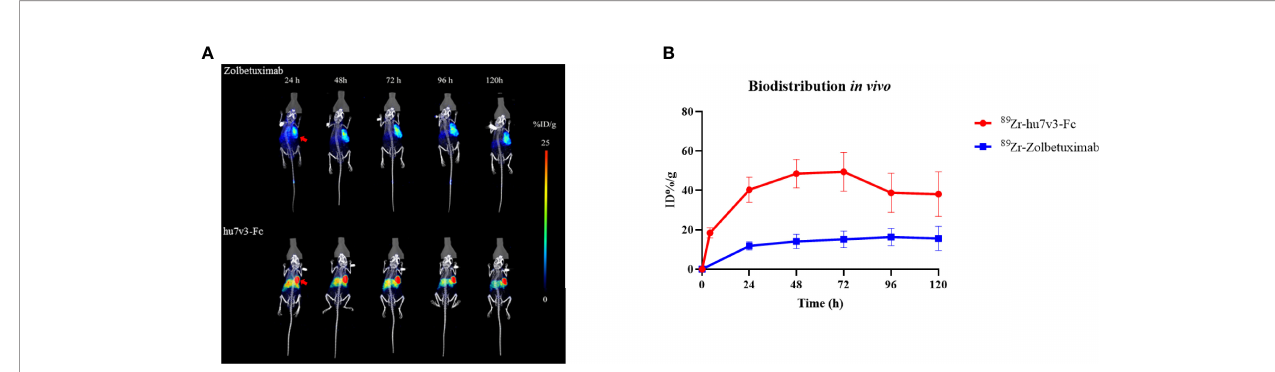
FIGURE 5 | In vivo tumor location of 89 Zr labeled 7v3-Fc. (A) 89 Zr PET-CT imaging in mice bearing subcutaneously SNU-620 tumors showed speci fi c tumor location. Red arrowheads indicate the location of tumors. (B) Time-radioactivity curves derived from PET-CT imaging after injection with 89 Zr labeled hu7v3-Fc and Zolbetuximab. Data are displayed with Mean ± SD (n =